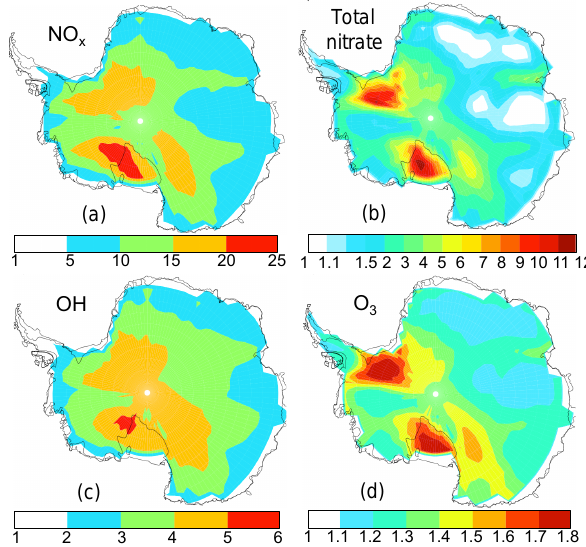
Figure 8. Factor increase in mean austral summer (DJF) boundary layer (a) NO x , (b) gas + aerosol-phase nitrate, (c) OH, and (d) O 3 mixing ratios between model runs with F NO F NO x